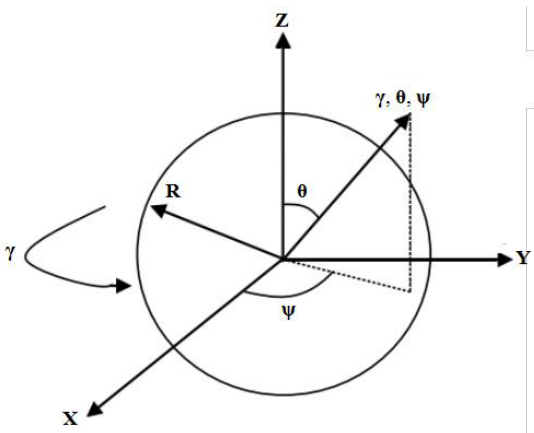
Figure 8. The spherical coordinate of undercooled melt.